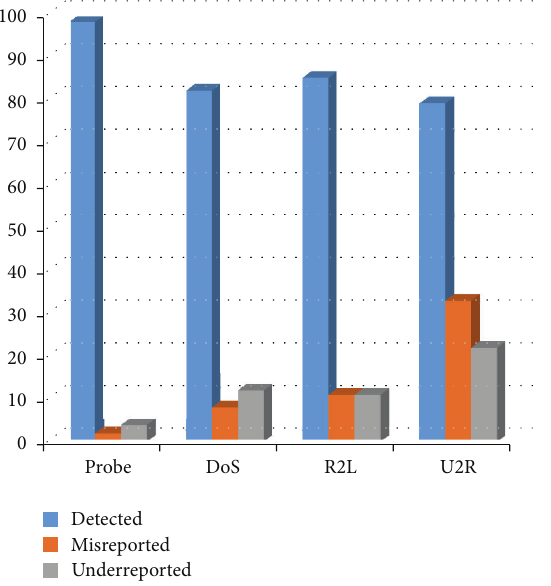
Figure 5: System performance indicators.